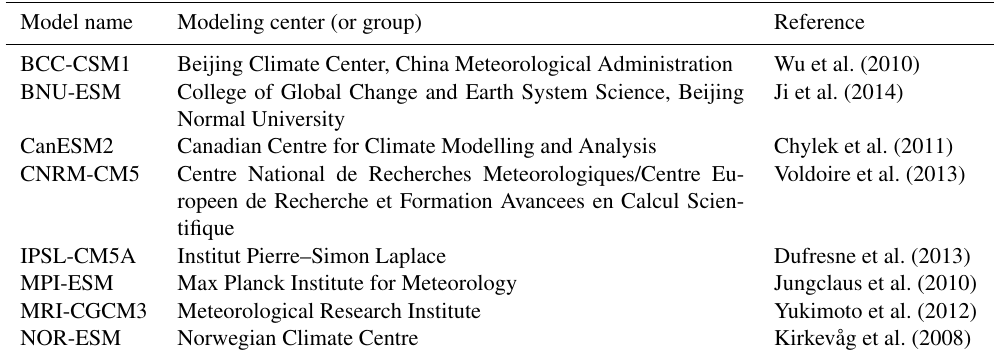
Table 3. AOGCMs considered in this study.